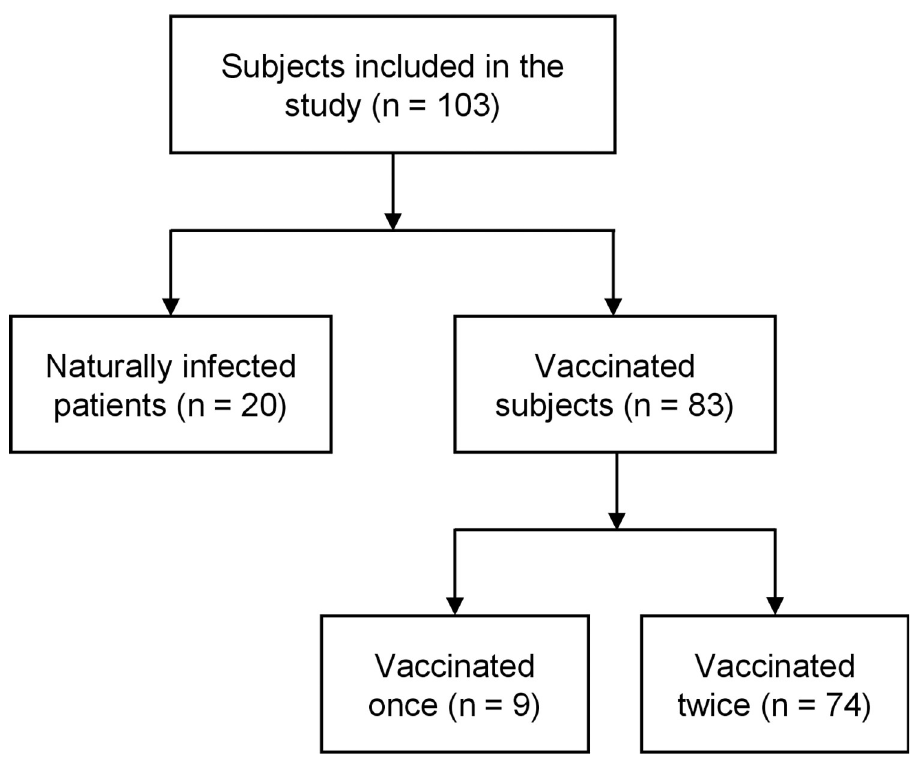
Fig 1. Subject groups. The flowchart indicates the grouping of the subjects in the